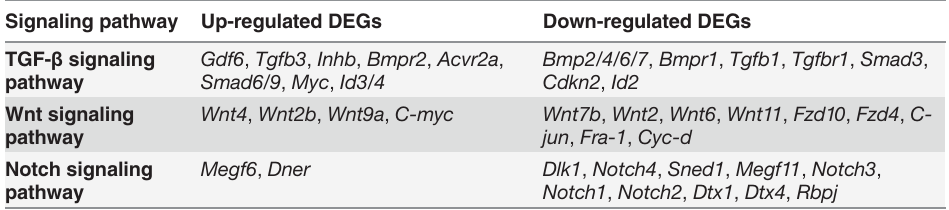
Table 4. List of possible signaling pathways and major DEGs involved in these